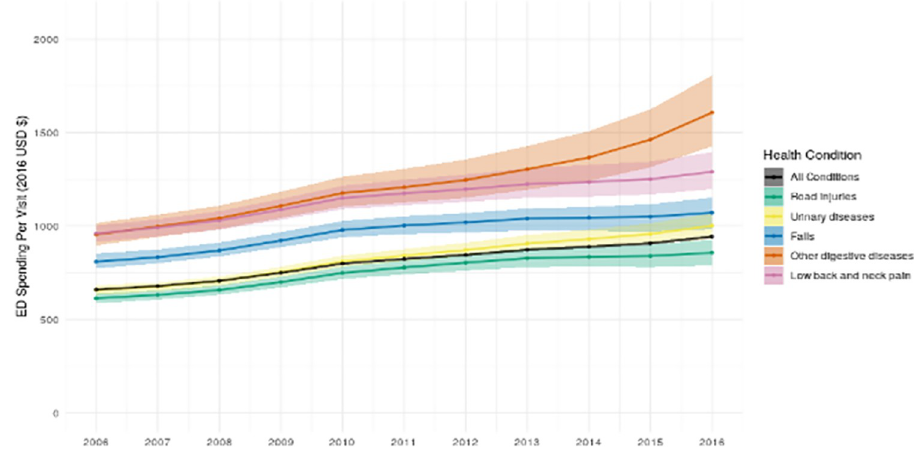
Fig 4. Emergency department spending per visit overall and for the 5 health conditions with the most ED spending in 2016.